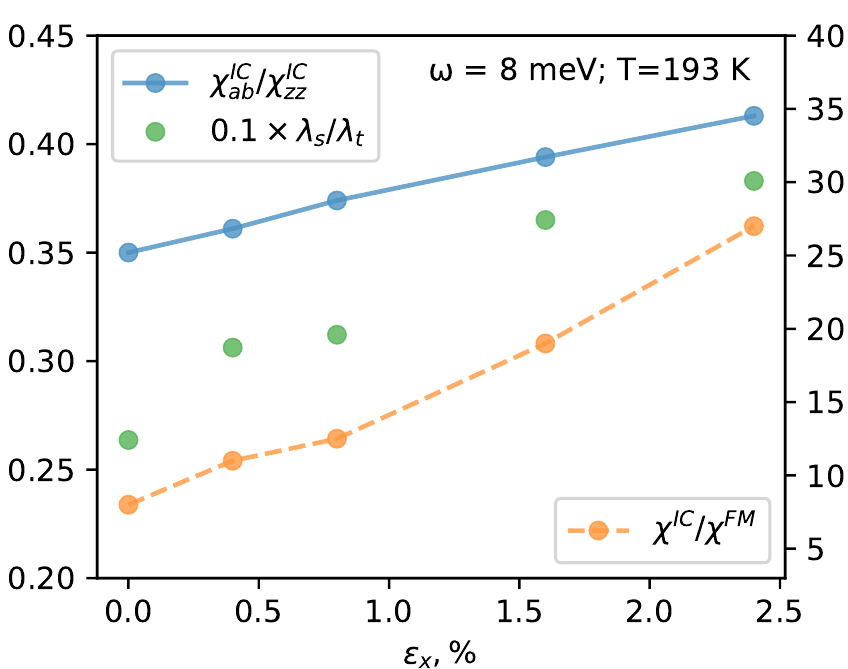
Figure 6. Magnetic anisotropy and incommensurability and their role in superconductivity: We show the evolution of the (inverse) magnetic anisotropy χ IC / χ IC zz , the relative strengths of the spin ab susceptibilities at IC and FM vectors χ IC / χ FM with strain (cid:101) x . We show that enhancement in singlet instability ( λ s / λ t ) is concomitant with both decreasing anisotropy and increasing quasi-AFM spin susceptibility. However, since λ s / λ t increases even without spin-orbit coupling, we infer that it is primarily the increment in the quasi-AFM spin fluctuation mediated glue in comparison to the FM spin fluctuations that drive the singlet